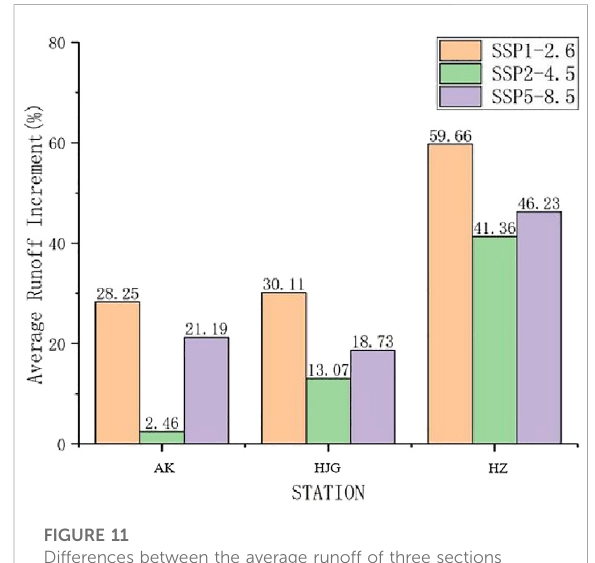
FIGURE 11 Differences between the average runoff of three sections from 2021 to 2060 and the reference period (%).